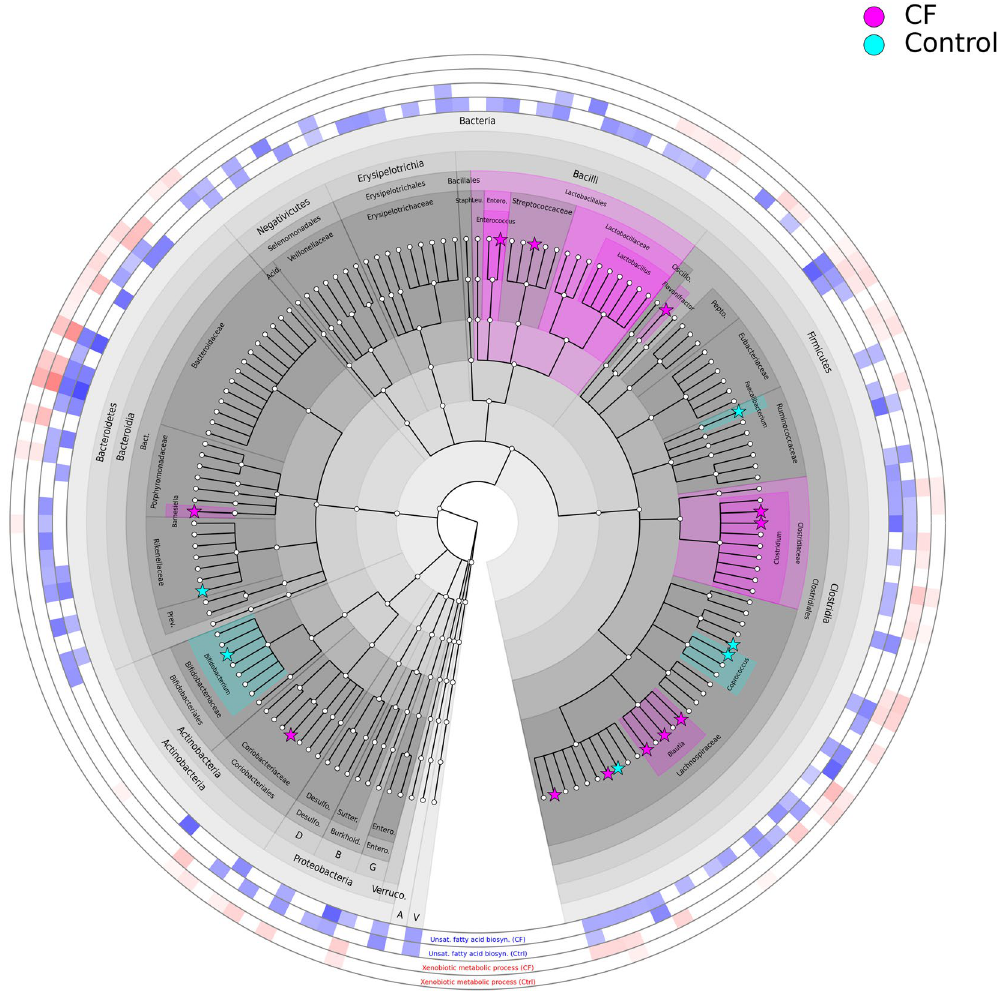
Figure 2. Cladogram presenting the microorganisms detected in stool samples from CF patients and controls using MetaPhlAn2, and the relative contribution of each microbial species to unsaturated fatty acid biosynthesis and xenobiotic metabolic processes, as determined by HUMAnN2. Pink clades indicate that taxa were significantly higher in CF patients whereas cyan clades indicate that taxa were significantly higher in controls. Stars are used to highlight species that were significantly different between the two groups. The outer rings indicate the abundance of unsaturated fatty acid biosynthesis pathways (blue) and xenobiotic metabolic process pathways (red) that was assigned to each species by